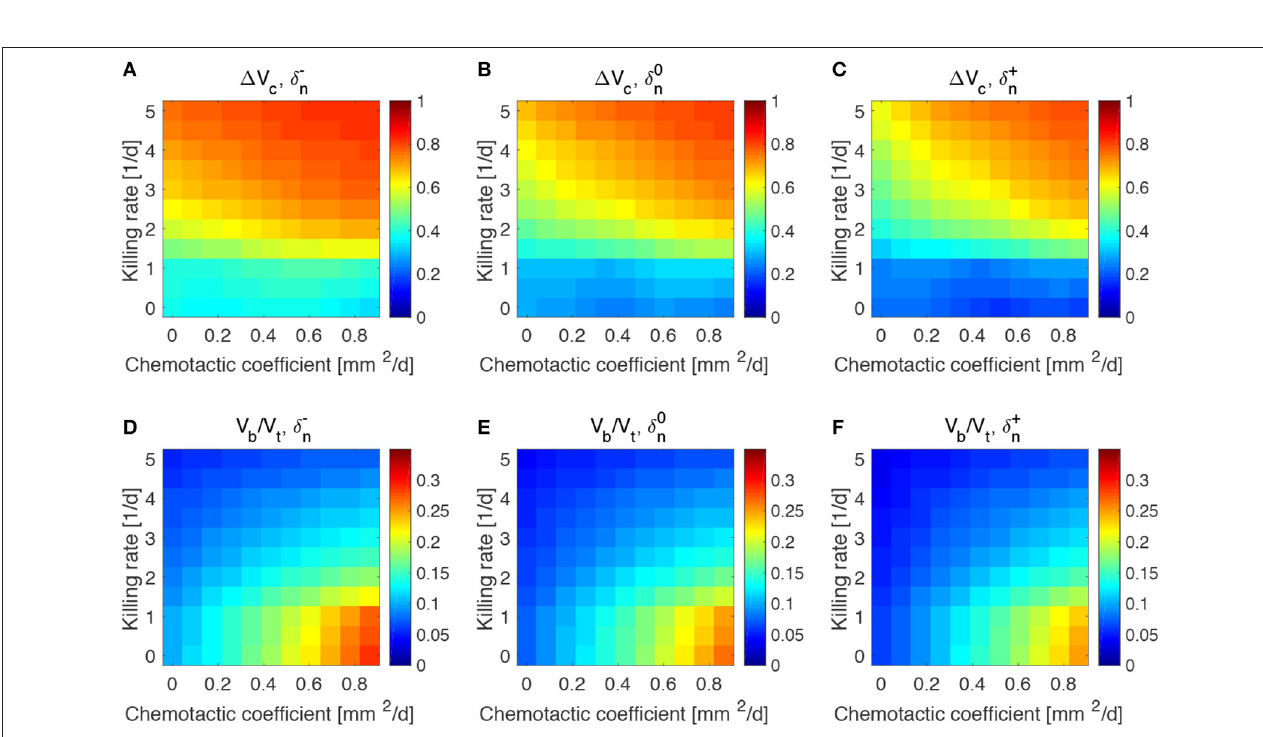
FIGURE 6 | Impact of tumor oxygen consumption rate on tumor and bacteria volumes at the end of the simulations (day 50). Relative tumor volume change and relative bacteria volume for low (A,D) , nominal (B,E) and high (C,F) tumor cell proliferation rate.